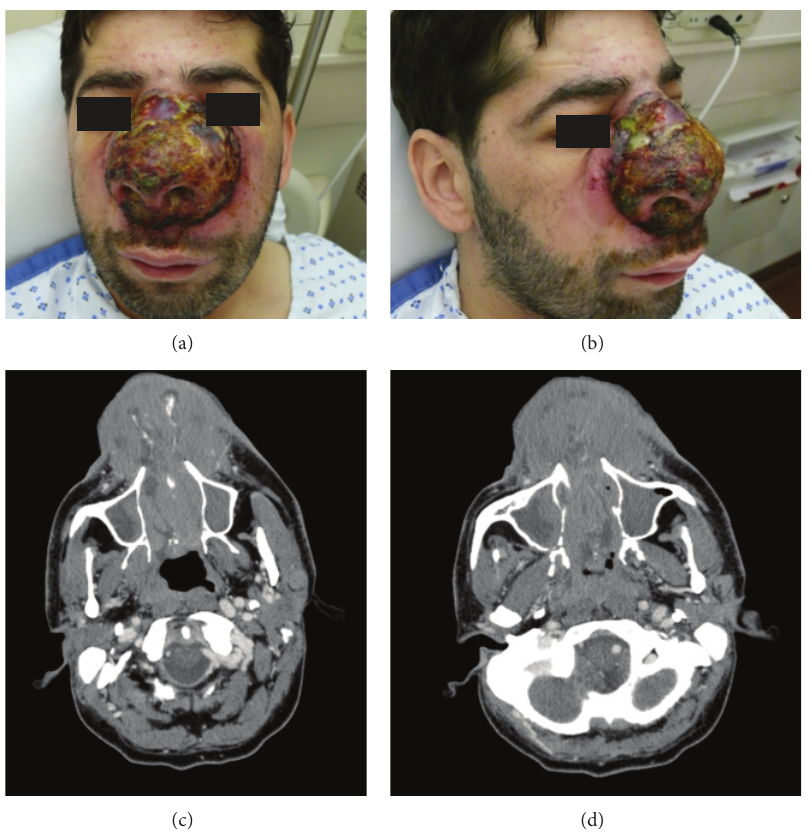
Figure 1: Pictures (a) and (b) showing anterior and lateral views of nasal granuloma from metastatic testicular ENKTCL-N lymphoma. Pictures (c) and (d) showing a CT of the sinuses with and without contrast, respectively, showing the nasal mass. Note: the patient had consented for the use of those pictures in research